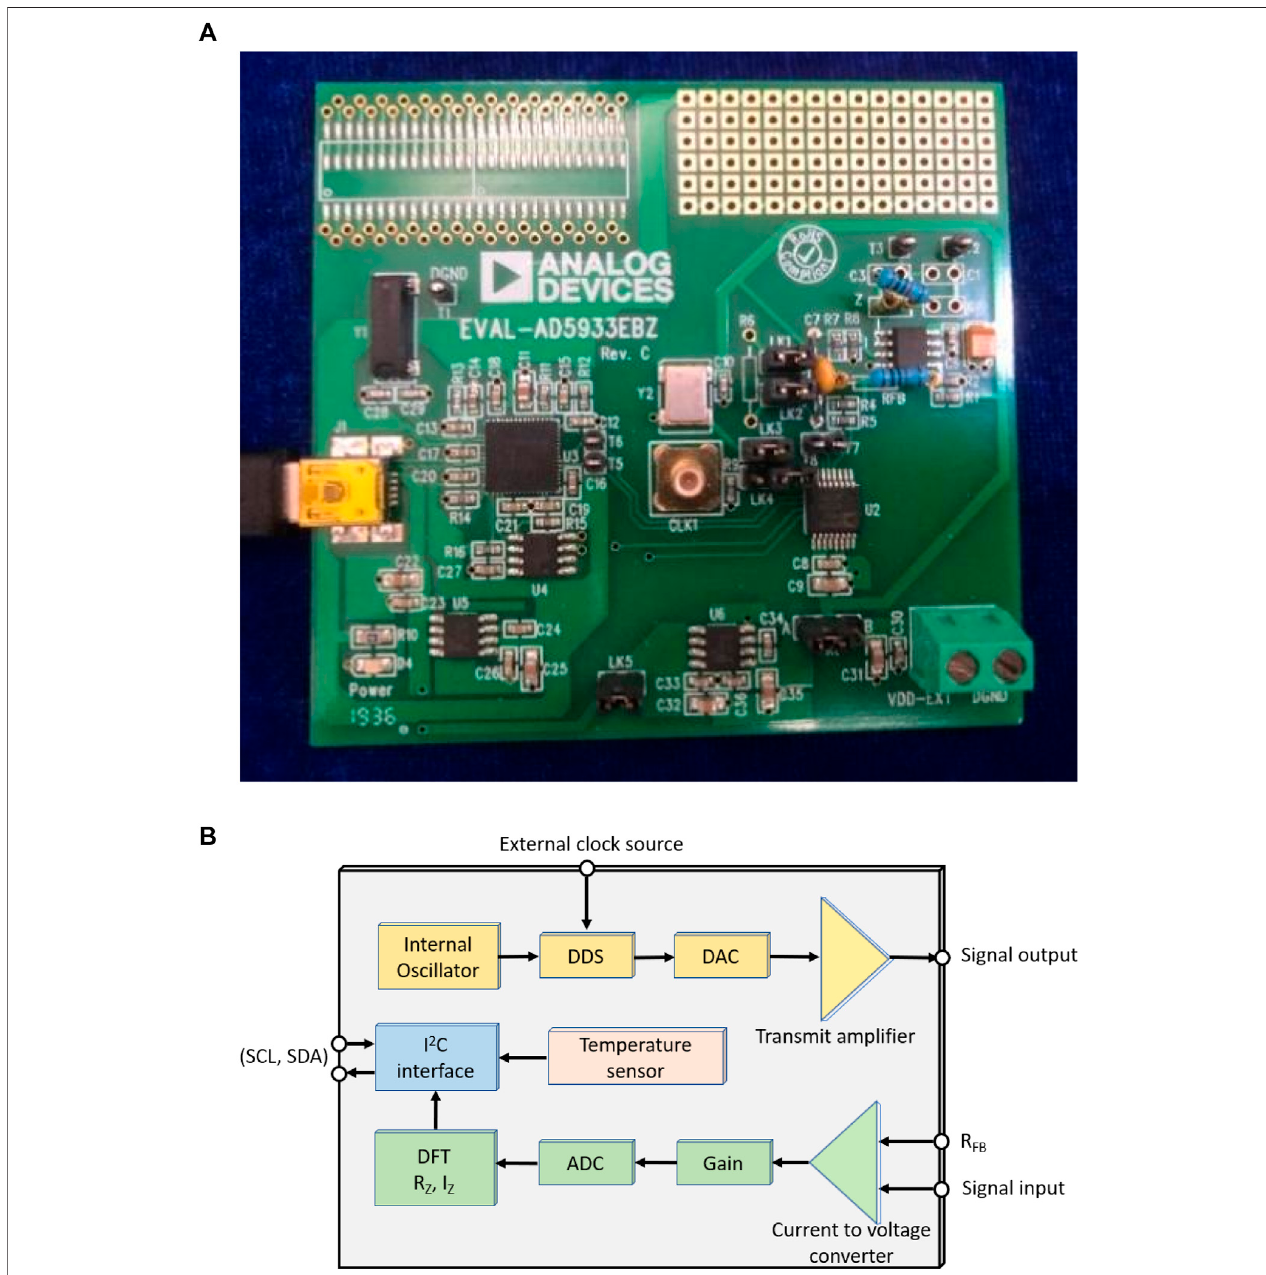
FIGURE 1 | AD5933 evaluation board (A) photo (B) block